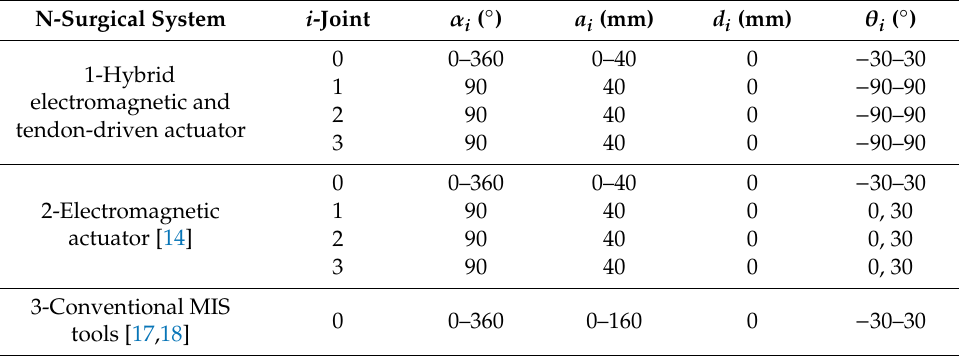
Table 2. Permissible movements of the hybrid electromagnetic and tendon-driven actuator, electromagnetic actuator, and conventional MIS